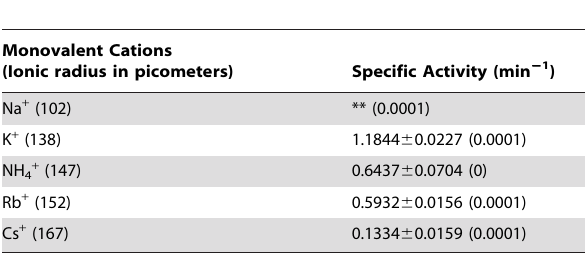
Table 1. YqeH Activity in Presence of Different Monovalent Cations.